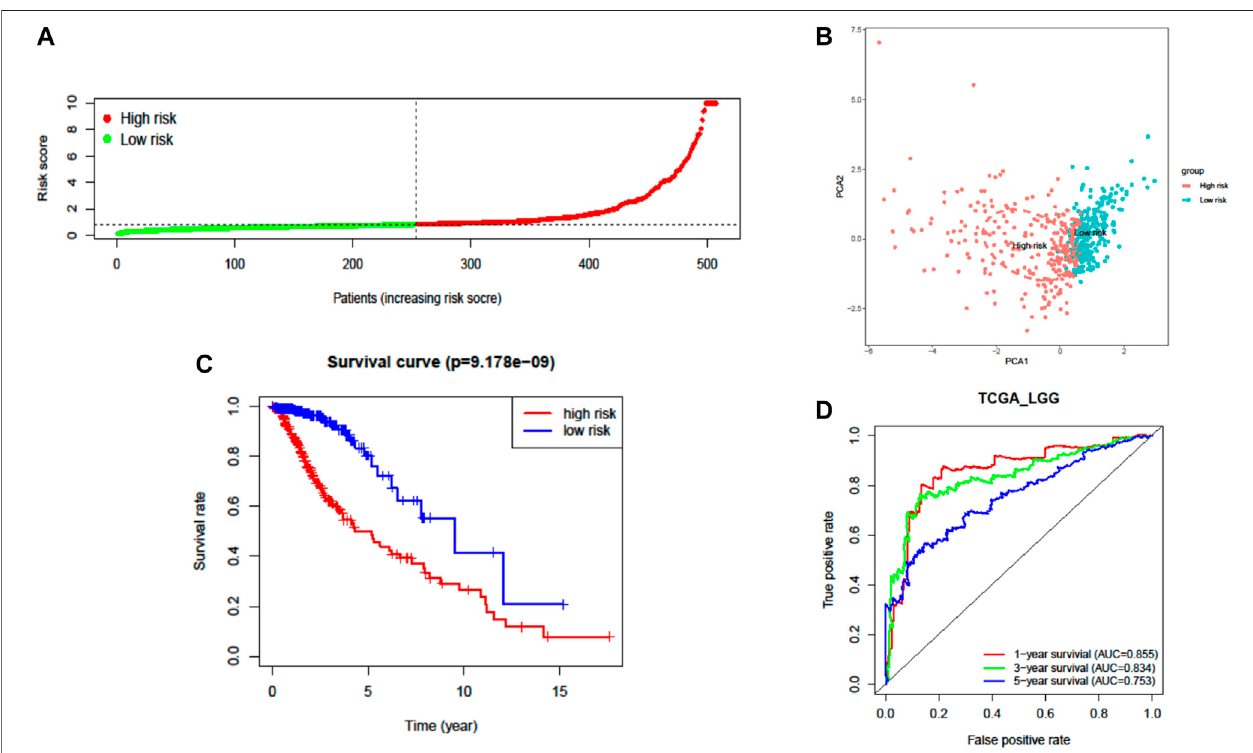
FIGURE 3 | Prognostic analysis of the seven-FRG signature model in TCGA cohort. (A) Distribution and median value of the risk scores. (B) PCA plot of TCGA cohort. (C) Kaplan – Meier curves for the OS of patients in the high-risk group and low-risk group. (D) The AUC of time-dependent ROC curves veri fi ed the prognostic performance of the risk